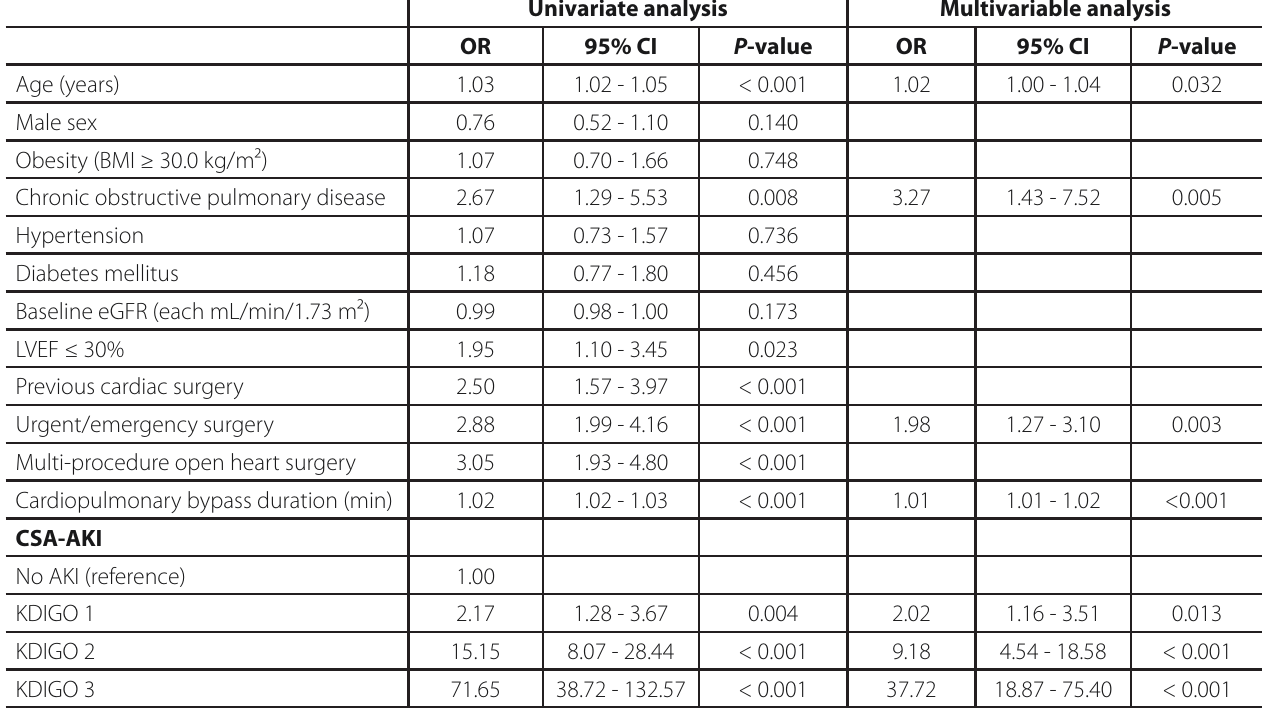
Table 4. Multivariable analysis using logistic regression models — odds ratio (OR) and 95% confidence intervals (CI) for predictors of hospital mortality up to 30 days after cardiac